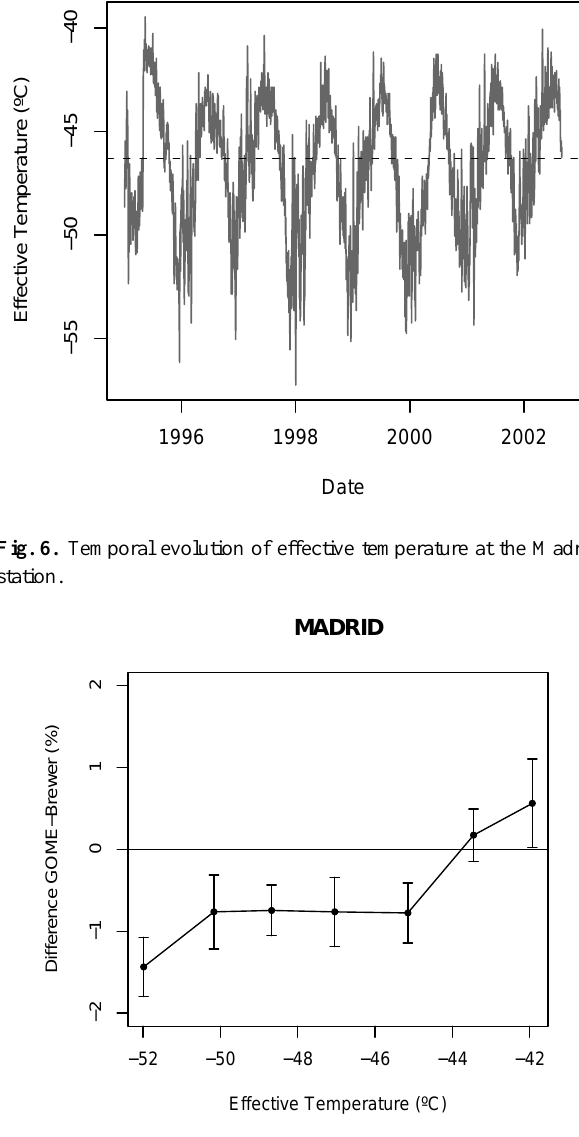
Fig. 7. Variation of GOME-Brewer relative differences with the effective temperature at the Madrid station.